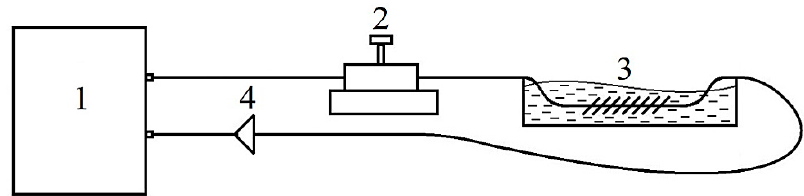
Figure 4. Experimental setup. 1 —multichannel interrogator, 2 —mechanical polarization controller, 3 —tank with the sensor immersed in liquid, 4 —optical fiber isolator.